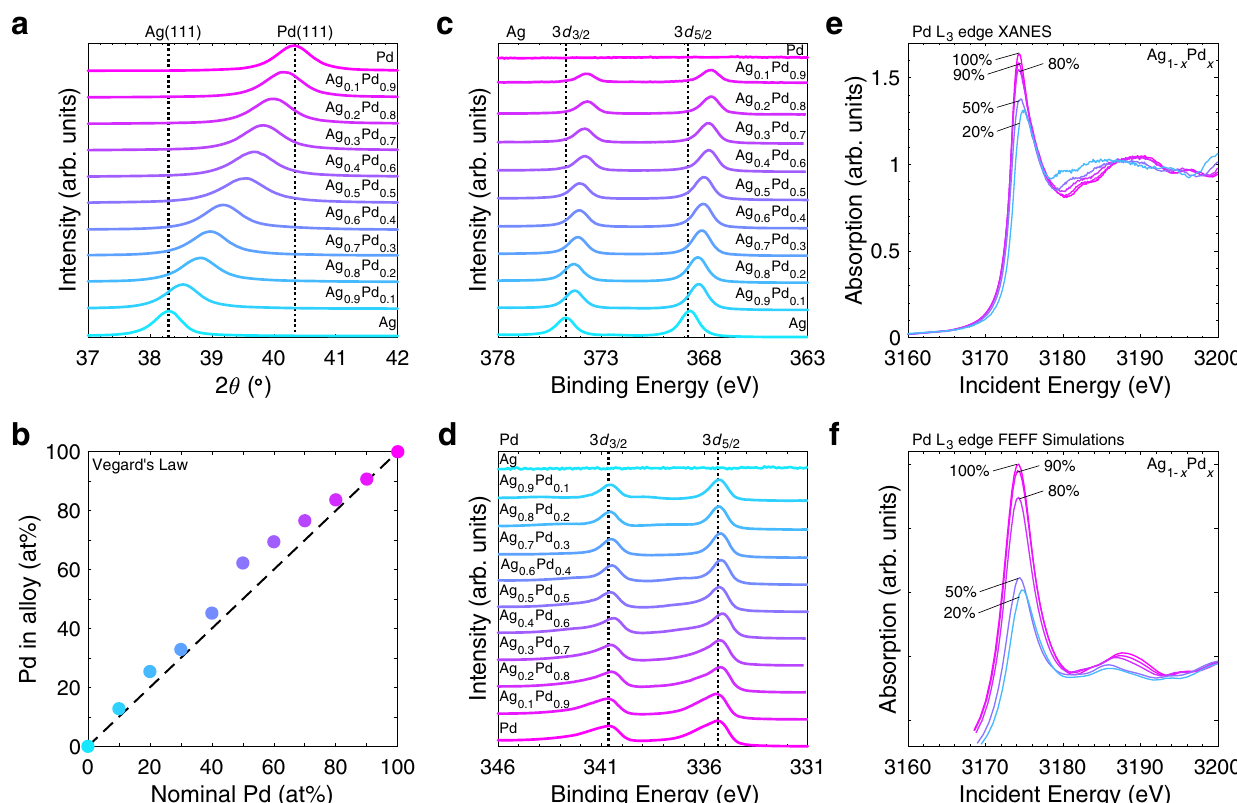
Fig. 1 X-ray diffraction and x-ray spectroscopies of Ag-Pd thin fi lms. a Grazing incidence x-ray diffractograms highlighting the (111) fcc peak as a function of Ag:Pd ratio in Ag 1- x Pd x fi lms. Ag (38.30°) and Pd (40.35°) (111) peak locations are indicated with dotted lines. (See expanded 2 θ range in Supplementary Fig. 1a, and symmetric-geometry diffractograms in Supplementary Fig. 2). b Vegard ’ s Law analysis of the (111) peak showing Pd content in the alloy versus nominal Pd composition. High resolution c Ag 3 d and d P d 3 d XPS spectra as a function of Ag:Pd ratio in Ag 1 – x Pd x fi lms (see survey spectra and XPS compositional analysis in Supplementary Figs. 3 and 4). e Normalized Pd L 3 x-ray absorption near-edge region spectra (Pd L 3 -edge XANES) for select Ag 1 – x Pd x compositions ( x = 1, 0.9, 0.8, 0.5, 0.2), and f FEFF simulated Pd L 3 -edge XANES for select Ag 1- x Pd x compositions ( x = 1, 0.9, 0.8, 0.5, 0.2). (See full XANES scan in Supplementary Fig. 5). All samples measured on standard glass slides for GI-XRD and on glassy carbon substrates for XPS and XANES. The colors refer to the nominal Pd loading, consistent with the text labels in the fi